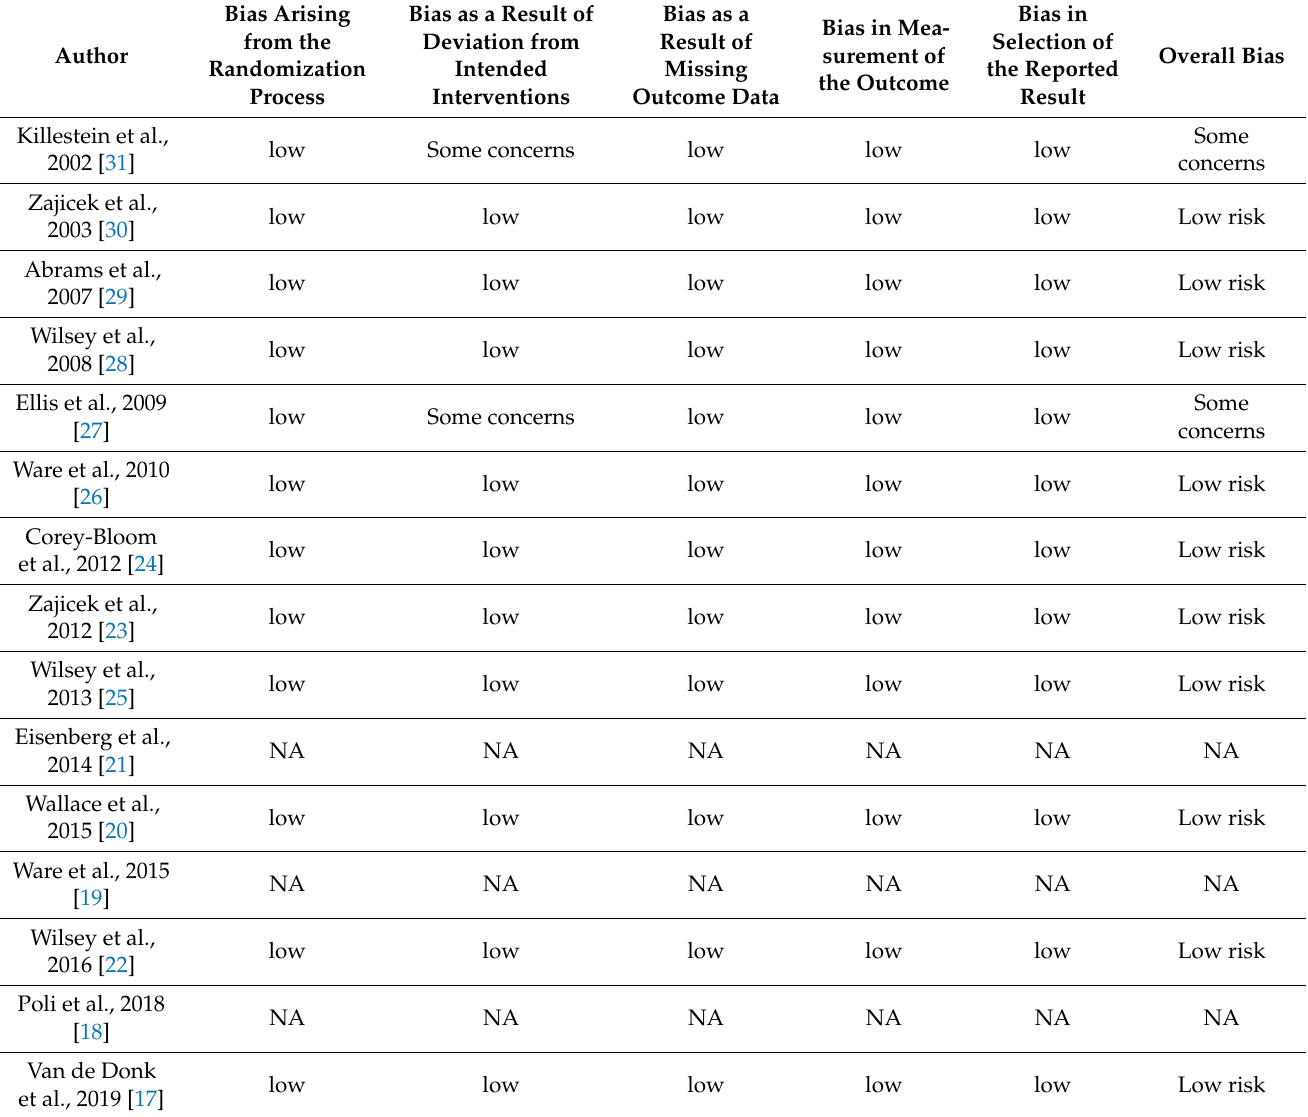
Table 3. Risk of Bias